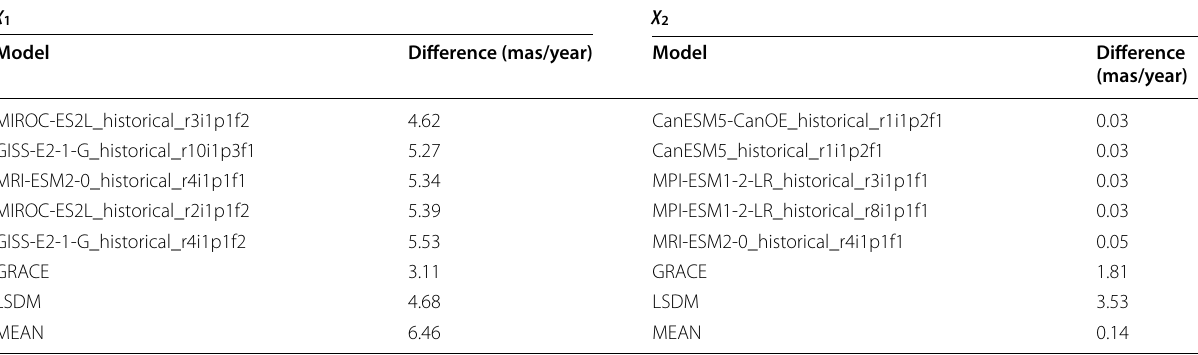
The results obtained from GRACE, LSDM, and MEAN model are also